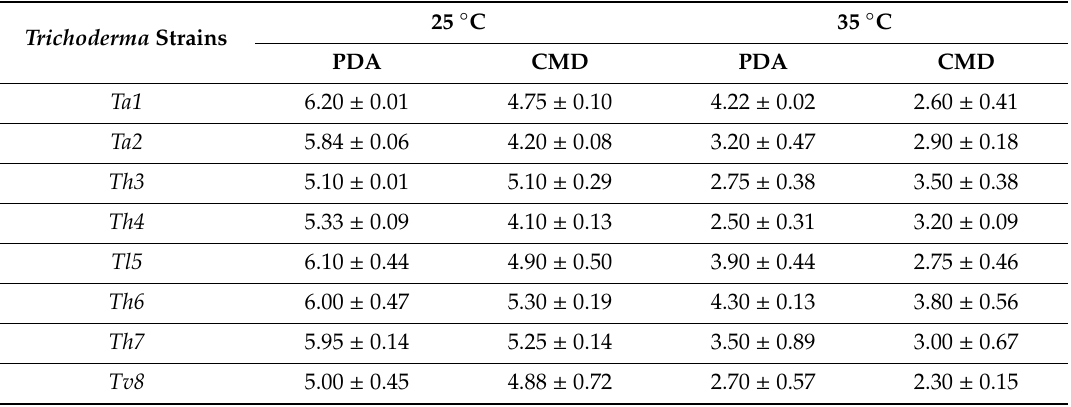
Table 3. The growth rate of Trichoderma strains on di ff erent media and at di ff erent incubation